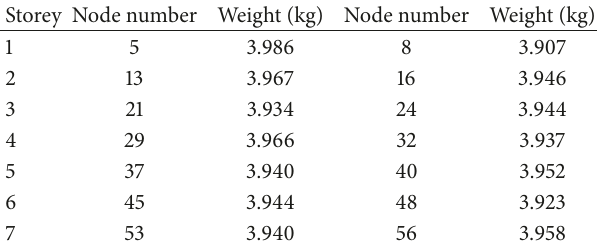
Table 9: Weights of mass